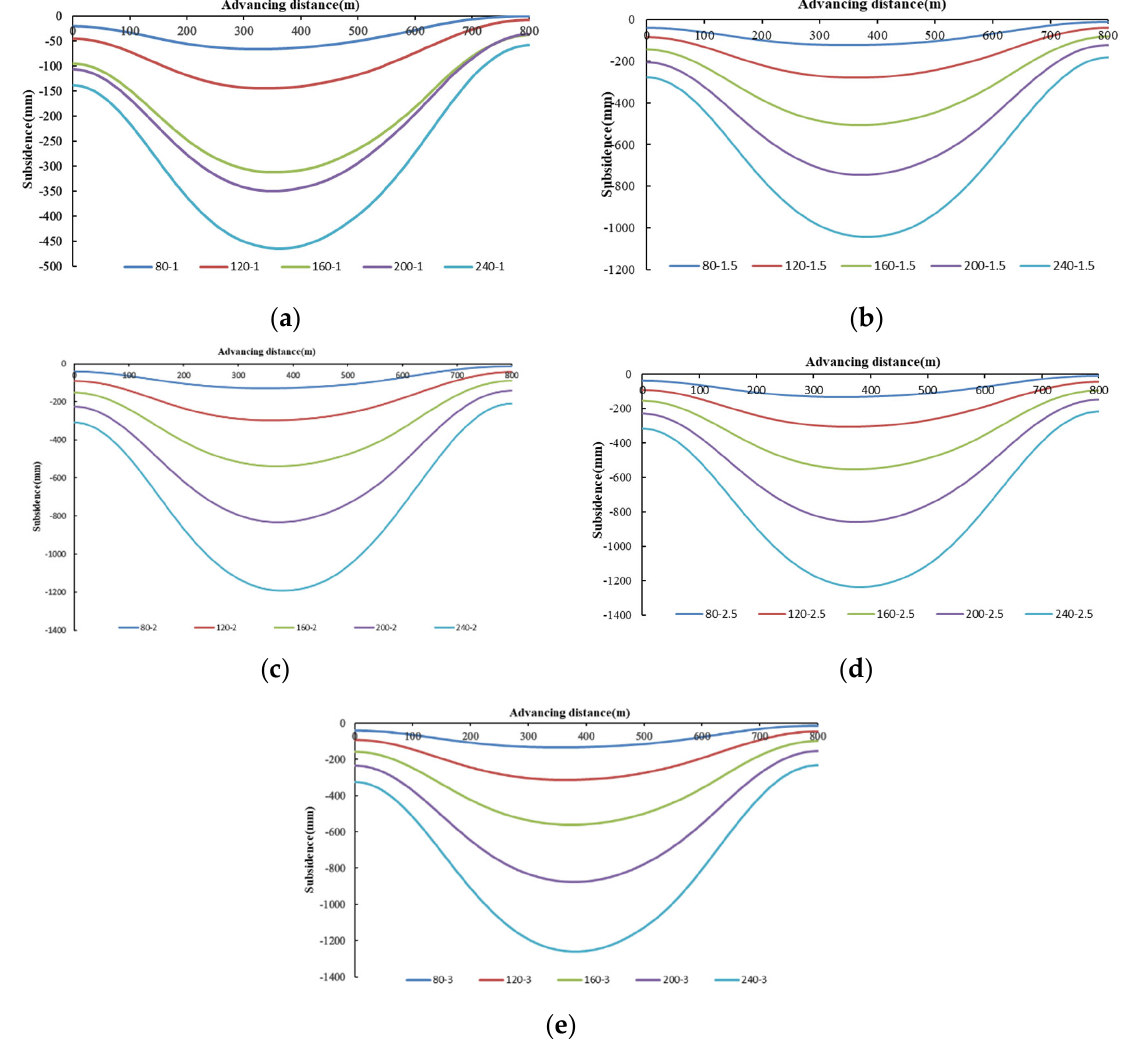
Figure 5. Overburden subsidence curves for the same mining height and different mining widths: ( a ) mining height is 1 m; ( b ) mining height is 1.5 m; ( c ) mining height is 2 m; ( d ) mining height is 2.5 m; ( e ) mining height is 3 m .